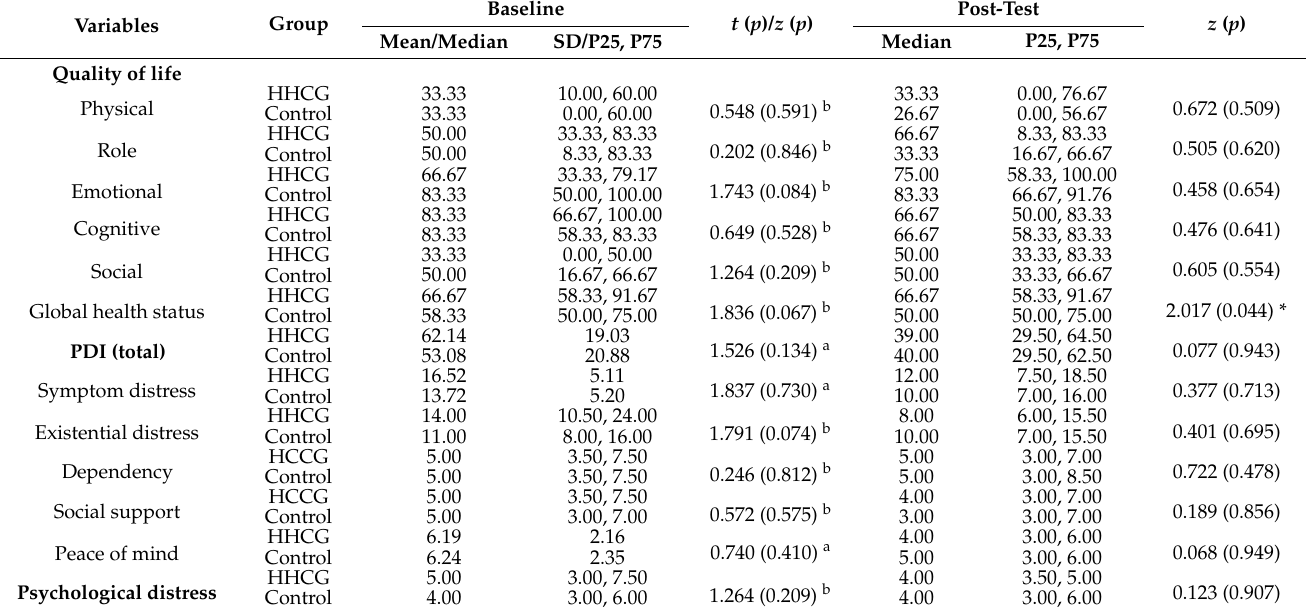
Table 2. Effects of the Heart to Heart Card Games on dignity, psychological distress, and quality of life in the intervention and control group at the 6-week follow-up ( n =